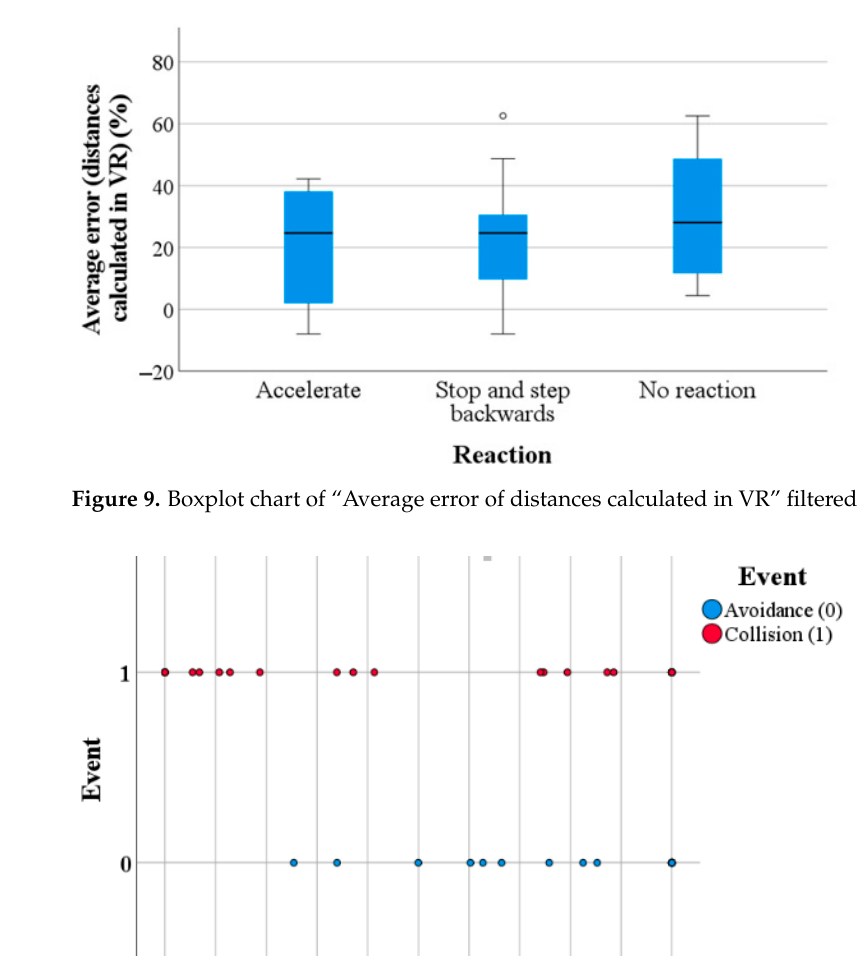
Figure 11. Change in total sickness measure of each stage. The SUS provides a broad global view of subjective assessments of usability. The SUS was administered to 29 participants. The results show a high mean SUS score across all participants at 82.9 (SD 11.6). Eighty-three percent of the participants assess the VR system as “Acceptable” and seventeen percent as “Marginal” (Figure 12), according to the accept- ability scores shown in Figure 4. There is no user who rated the system as “Not accepta- ble” (SUS less than 50).